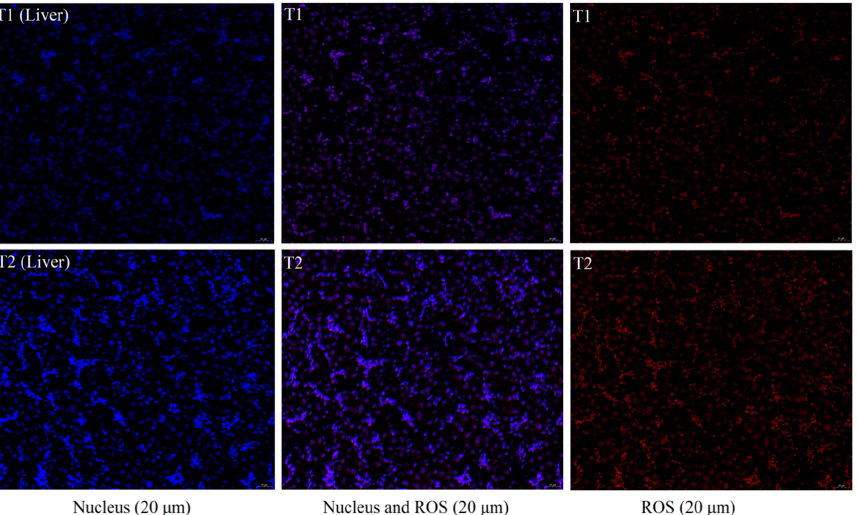
Figure 2. Fluorescent staining of liver and breasts for ROS. T1: not transported group (control); T2: transported group (for 4 h). Nuclei are shown in blue, and ROS are shown in red. The scale bar is 100 μ m and 20 μ m.